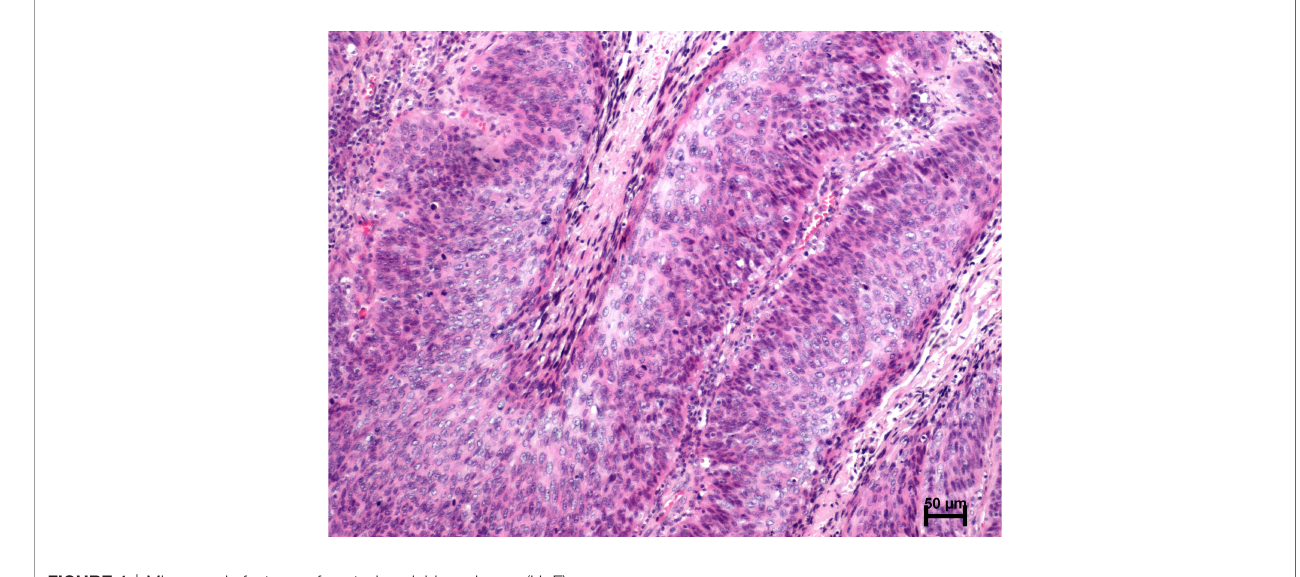
FIGURE 1 | Microscopic features of warty – basaloid carcinoma (H+E).